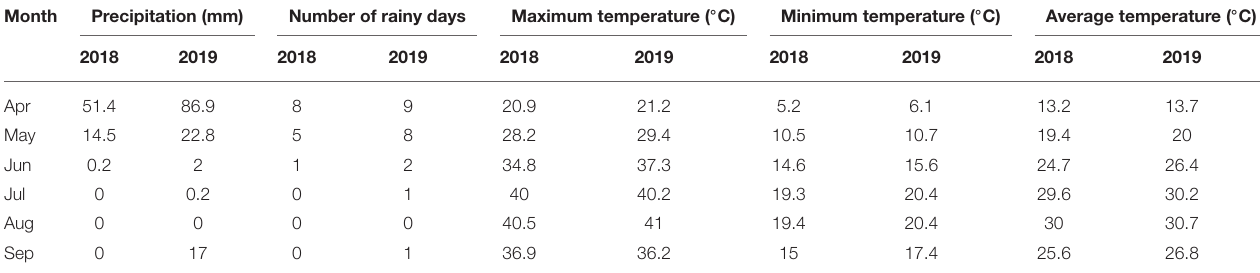
TABLE 1 | Khorramabad meteorological station monthly statistics in the experiment period in 2018 and 2019. Month